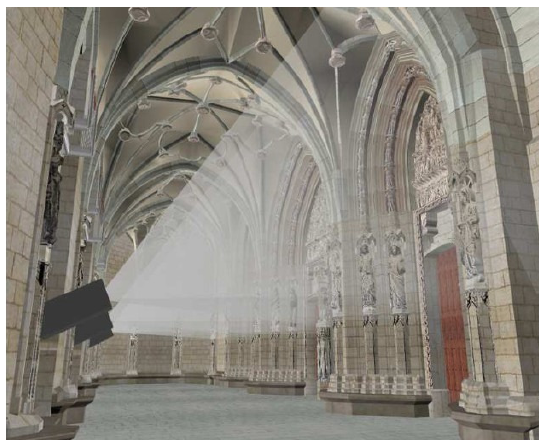
Figure 3. Interactive 3D application AR using viewing